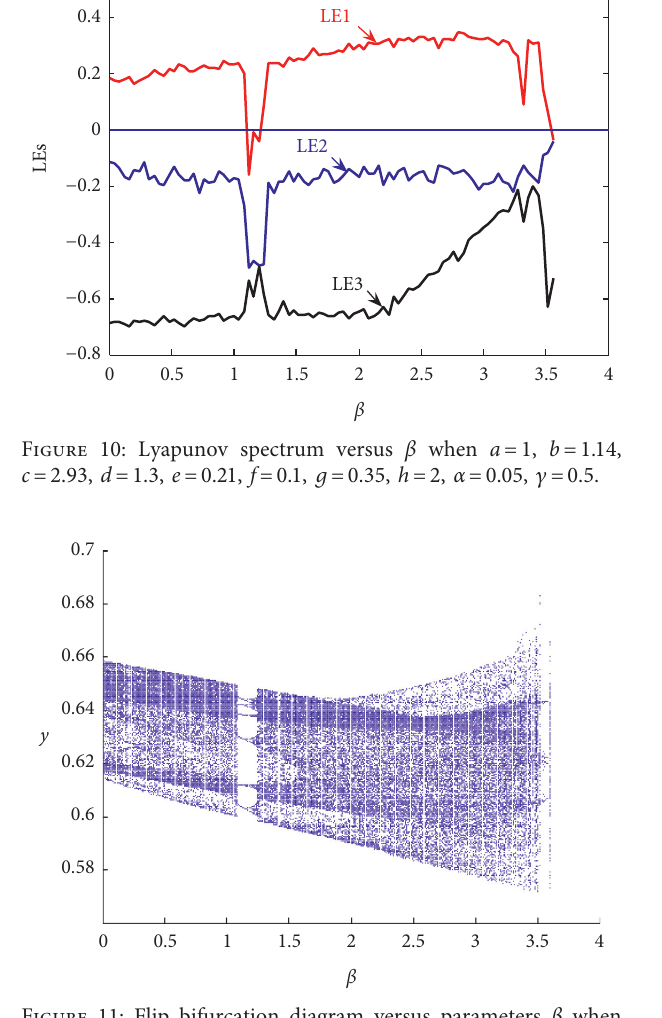
Figure 14: x – n sequence diagram which denotes that the system is chaotic when β � 3.